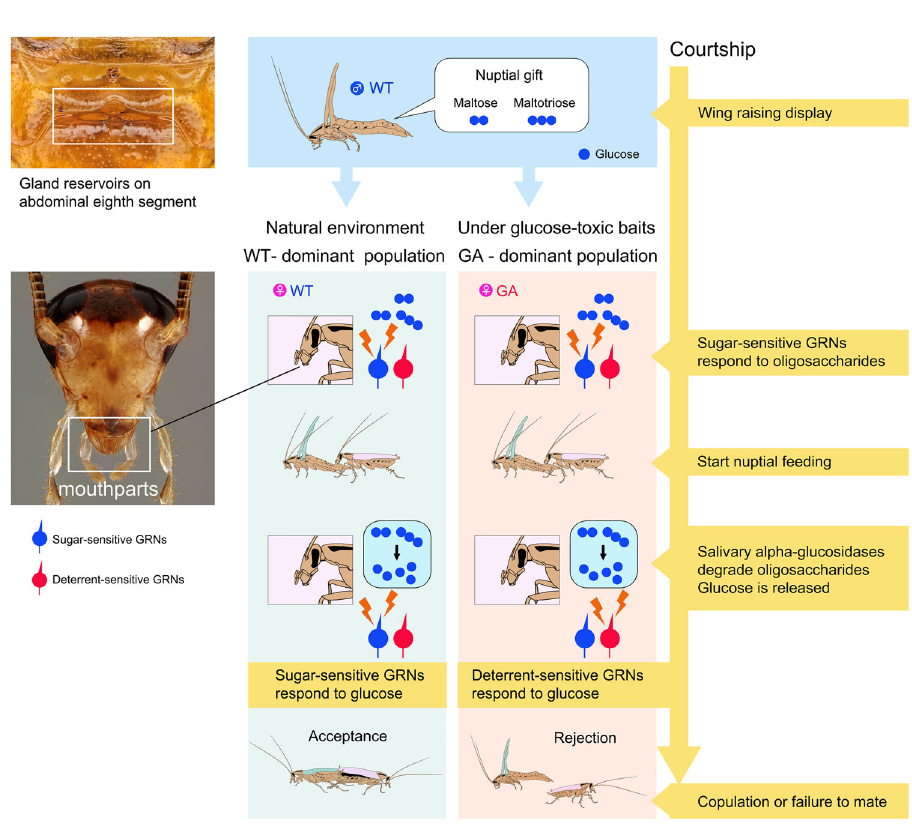
Fig. 5 Summary illustrating the divergent effects of a gustatory polymorphism on survival and sexual behavior. Maltose and maltotriose contained in the male ’ s nuptial secretion (upper left) stimulate the female ’ s mouthparts (lower left) and lure the female to mount the courting male. Initially, both WT and GA females accept the secretion and commence nuptial feeding because oligosaccharides stimulate sugar-sensitive GRNs. However, during nuptial feeding saliva is secreted, salivary alpha-glucosidases hydrolyze the oligosaccharides, and free glucose is released. Glucose stimulates deterrent-sensitive GRNs of GA females, resulting in interrupted nuptial feeding. In contrast, glucose is highly appetitive to WT females, and they continue to feed on the nuptial secretion; longer nuptial feeding enables the male to grasp the female ’ s genitalia and copulate. Thus, the GA trait is highly adaptive for cockroach survival in the presence of glucose-containing toxic baits, but it interferes with sexual signaling by the male and results in lower mating success of GA females, especially with WT